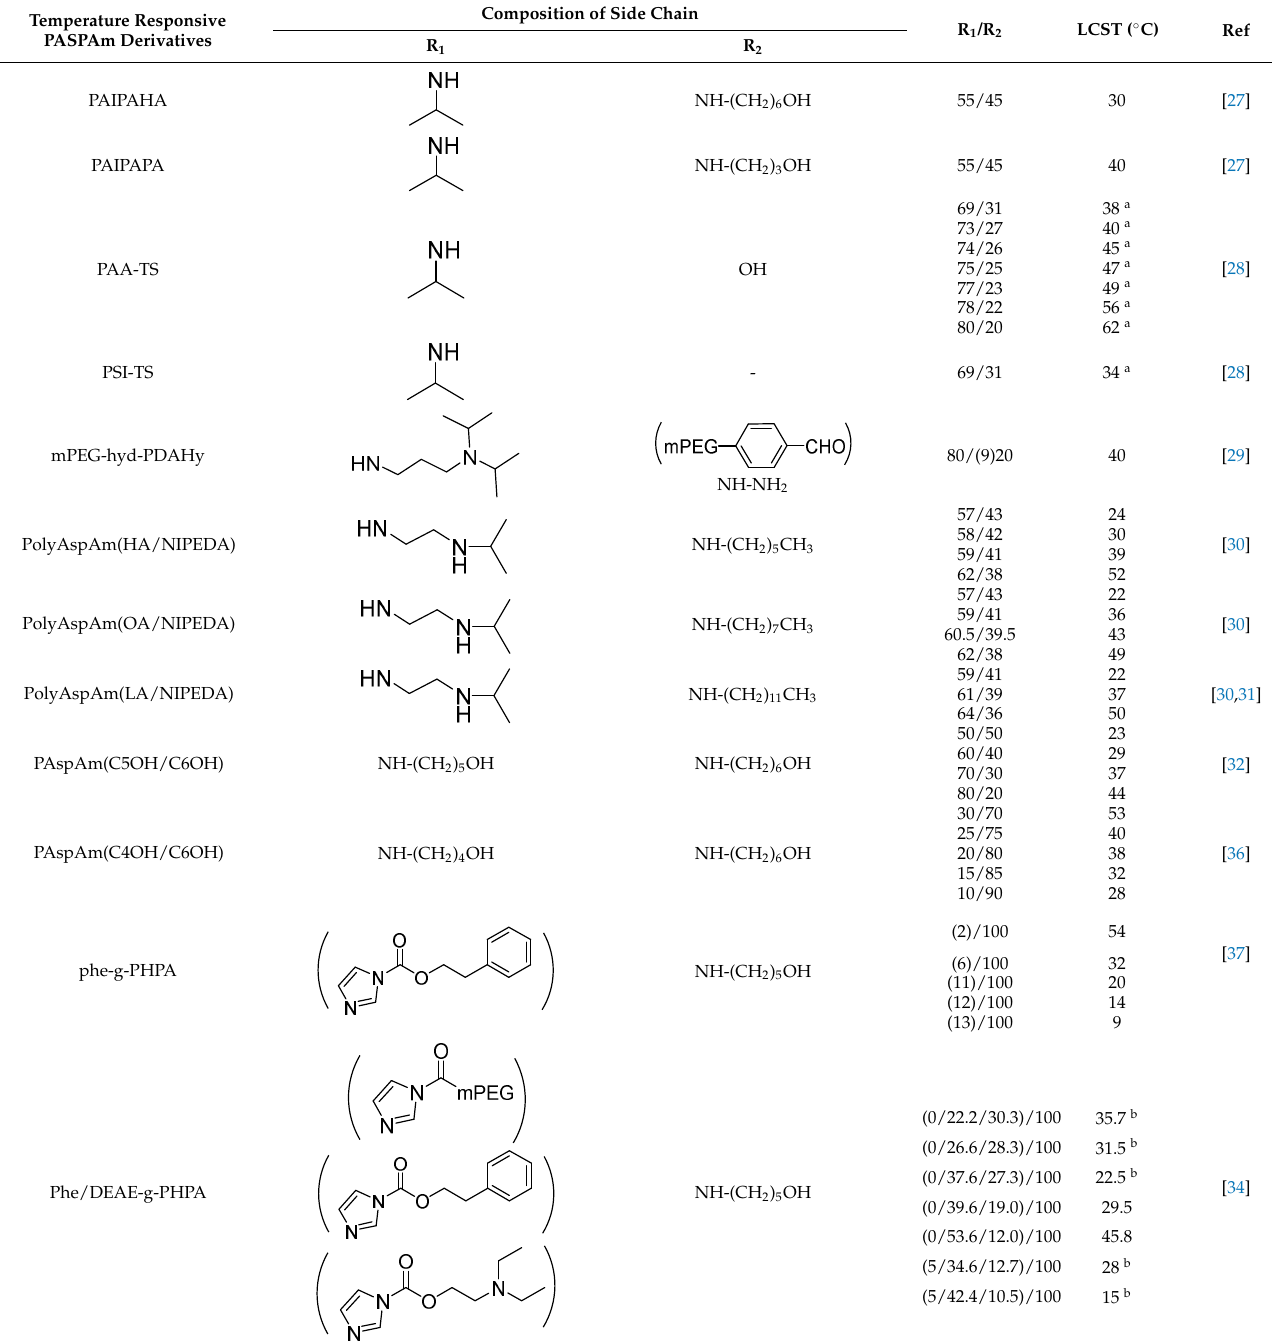
Table 1. A summary of temperature-responsive PASPAm derivatives.